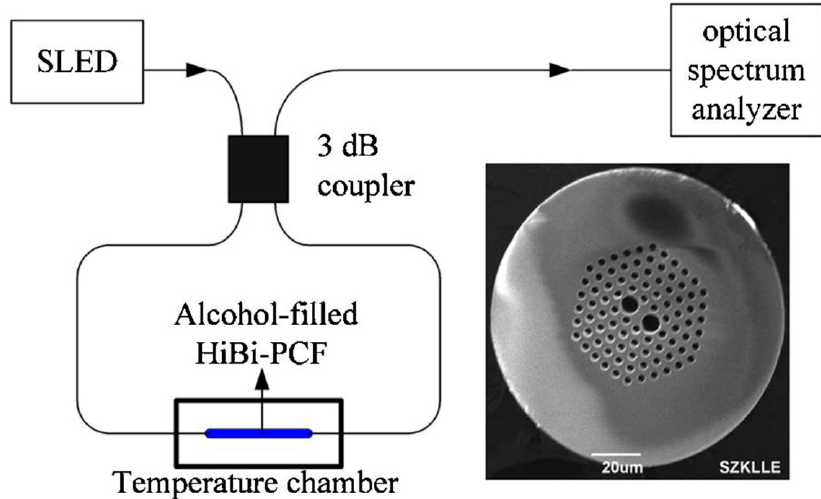
Figure 2. Experimental setup for a temperature sensor based on an FLM. Inset: SEM of the used HiBi-PCF [reprinted with permission from [49] © The Optical Society].